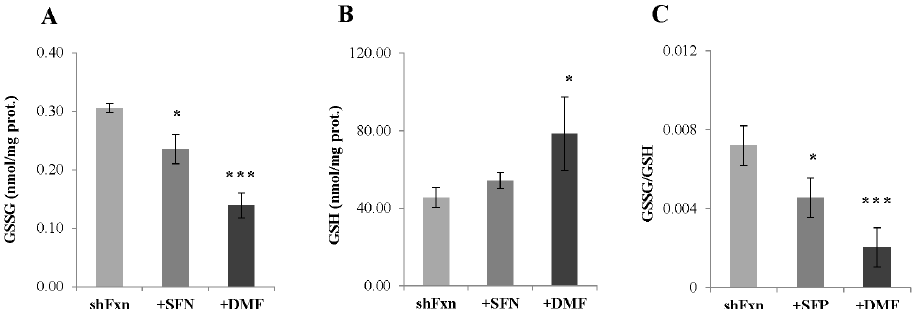
Figure 3. HPLC analysis of GSSG ( A ) and GSH ( B ) in shFxn after treatments with 5 µM (24 h) SFN and 30 µM (24 h) DMF. Nrf2 inducers cause repletion of the oxidized (GSSG)/reduced (GSH) glutathione ratio ( C ). * p < 0.05, *** p < 0.001, with respect to Mock.